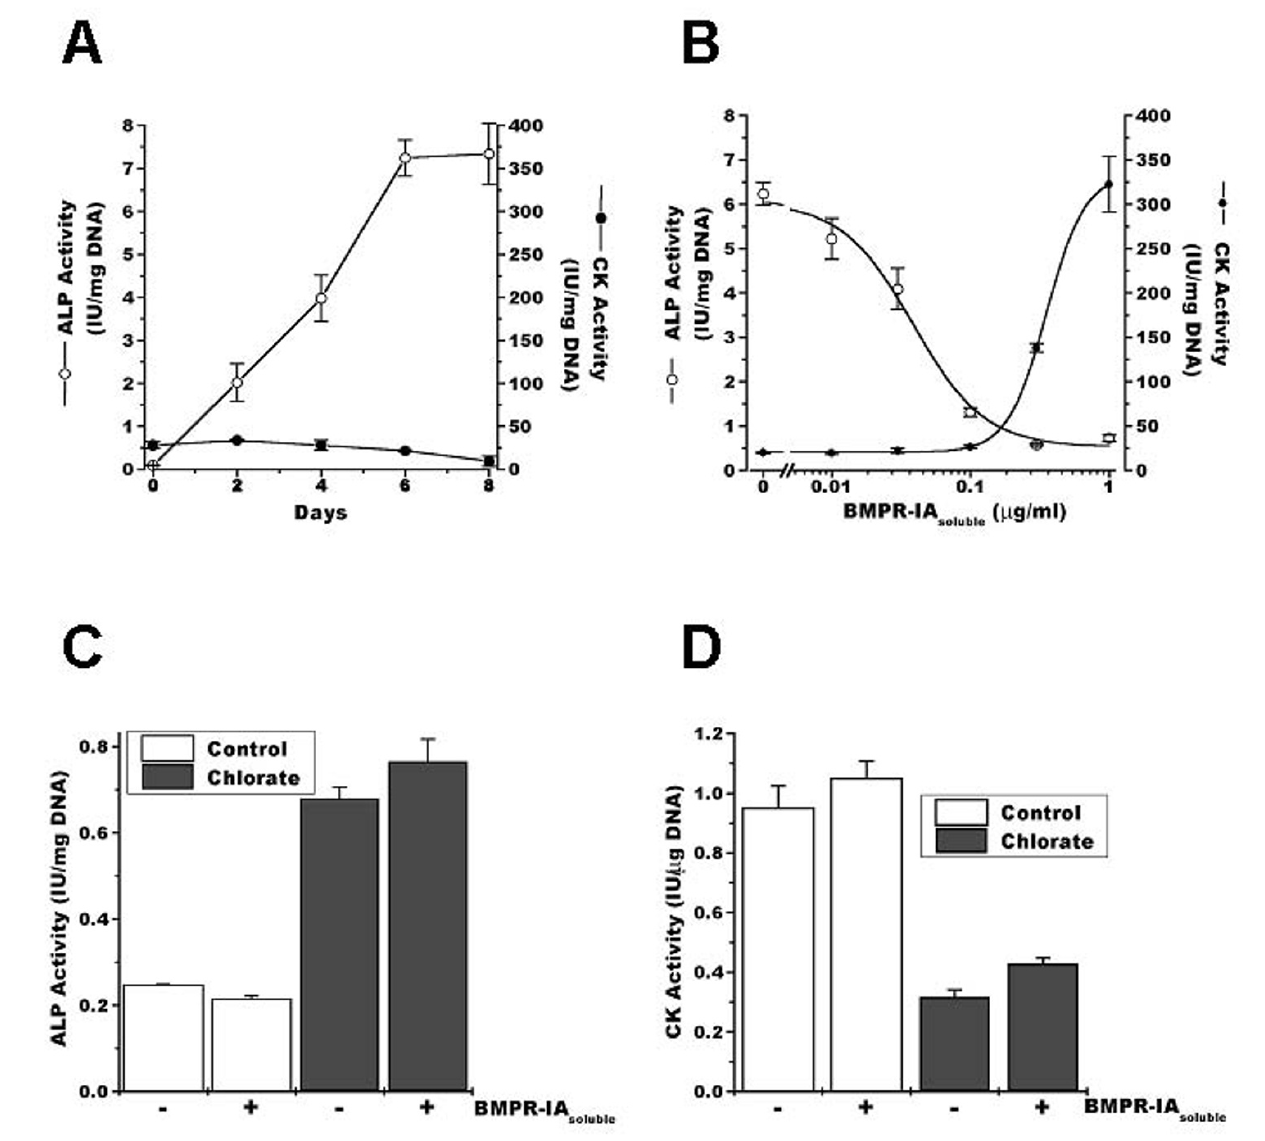
Figure 5 Alkaline phosphatase activity induced by inhibition of proteoglycan sulfation is not BMP-2 dependent . A . C2C12 cells were induced to differentiate in the presence of 5 nM BMP-2. ALP (open circles) and CK (closed circles) activity was determined as a function of time. The mean ± S.D. of two independent experiments performed in triplicate is presented. B . C2C12 cells were induced to differentiate in the presence of 5 nM BMP-2 and different concentrations of soluble BMP recep- tor IA (BMPR-IA ). ALP (open circles) and CK (closed circles) activity was determined at day 6. Values presented as mean ± S.D. of two independent experiments performed in triplicate. C2C12 cells were induced to differentiate either in the absence (control) or presence of 30 mM sodium chlorate (chlorate) or 1 μ g/ml soluble BMP receptor IA (BMPR-IA ( C ) and CK ( D ) activity was determined at day 8 days. The mean ± S.E.M, of two independent experiments performed in trip- licate is presented. ANOVA analysis followed by Tukey-Kramer multiple comparisons test shows that there are no statistically significant differences (p > 0.05) within the control or chlorate conditions. All other comparisons are significantly different (p <